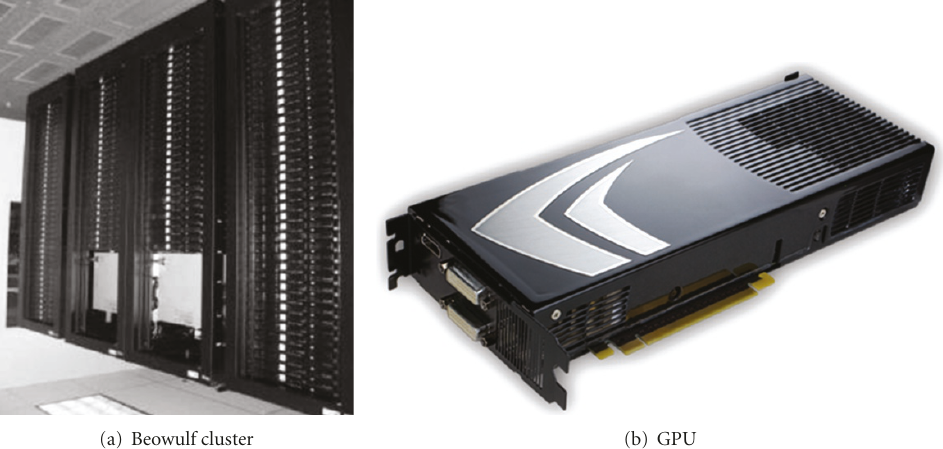
Figure 13: (a) Thunderhead Beowulf cluster at NASA’s Goddard Space Flight Center in Maryland. (b) NVidia GeForce 9800 GX2 GPU.